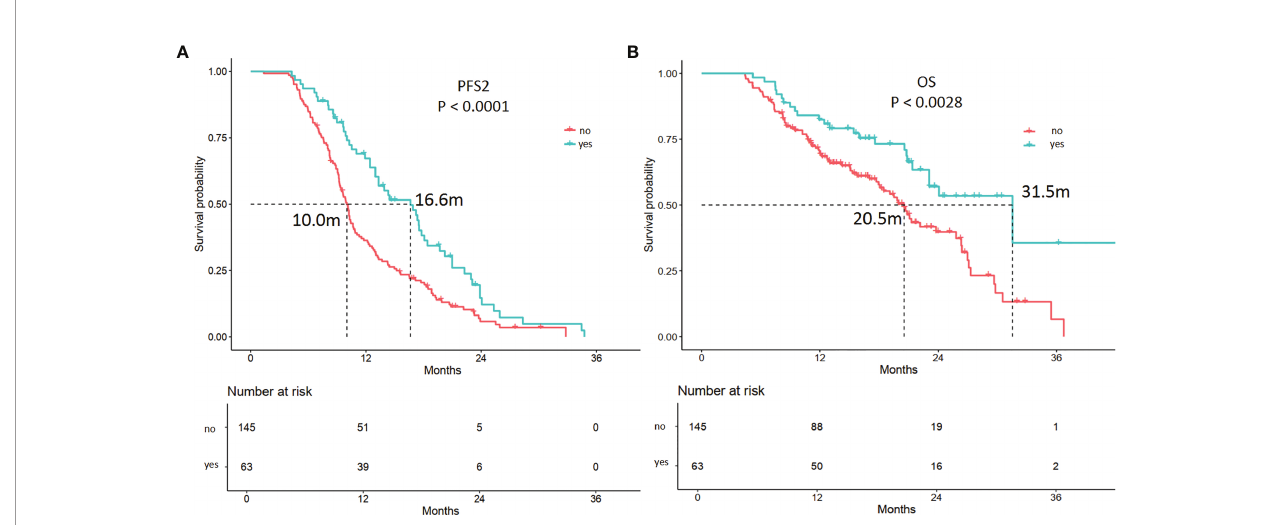
FIGURE 5 | Kaplan-Meier curves of the PFS2 and overall survival (OS) of patients receiving antiangiogenic therapy or not. (A) The mPFS2 were 16.6 and 10.0 months in patients receiving antiangiogenic therapy (yes) or not ( p = 0.00), respectively. (B) The mOS were 31.5 and 20.5 months in patients receiving antiangiogenic therapy (yes) or not ( p = 0.00), respectively.